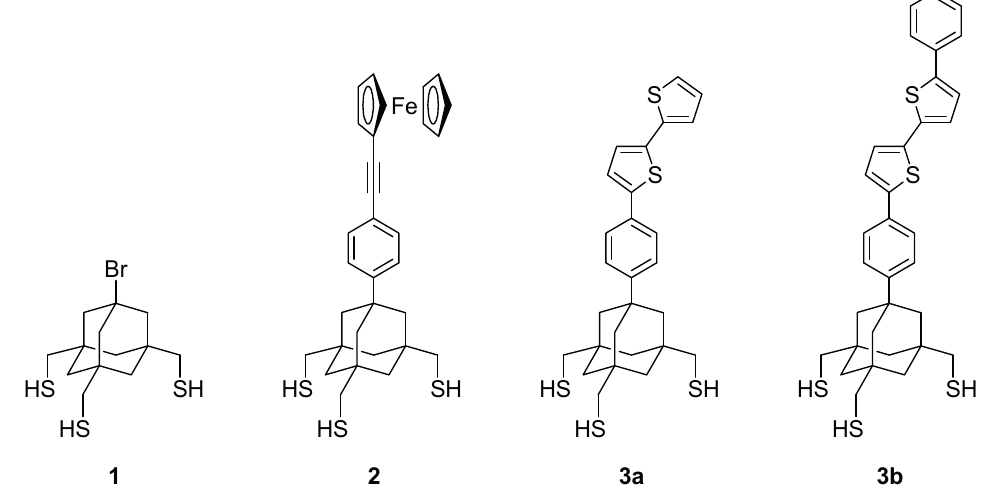
Figure 1. Structures of tripod-shaped trithiols with an adamantane core. The structures of 3a and 3b represent anti